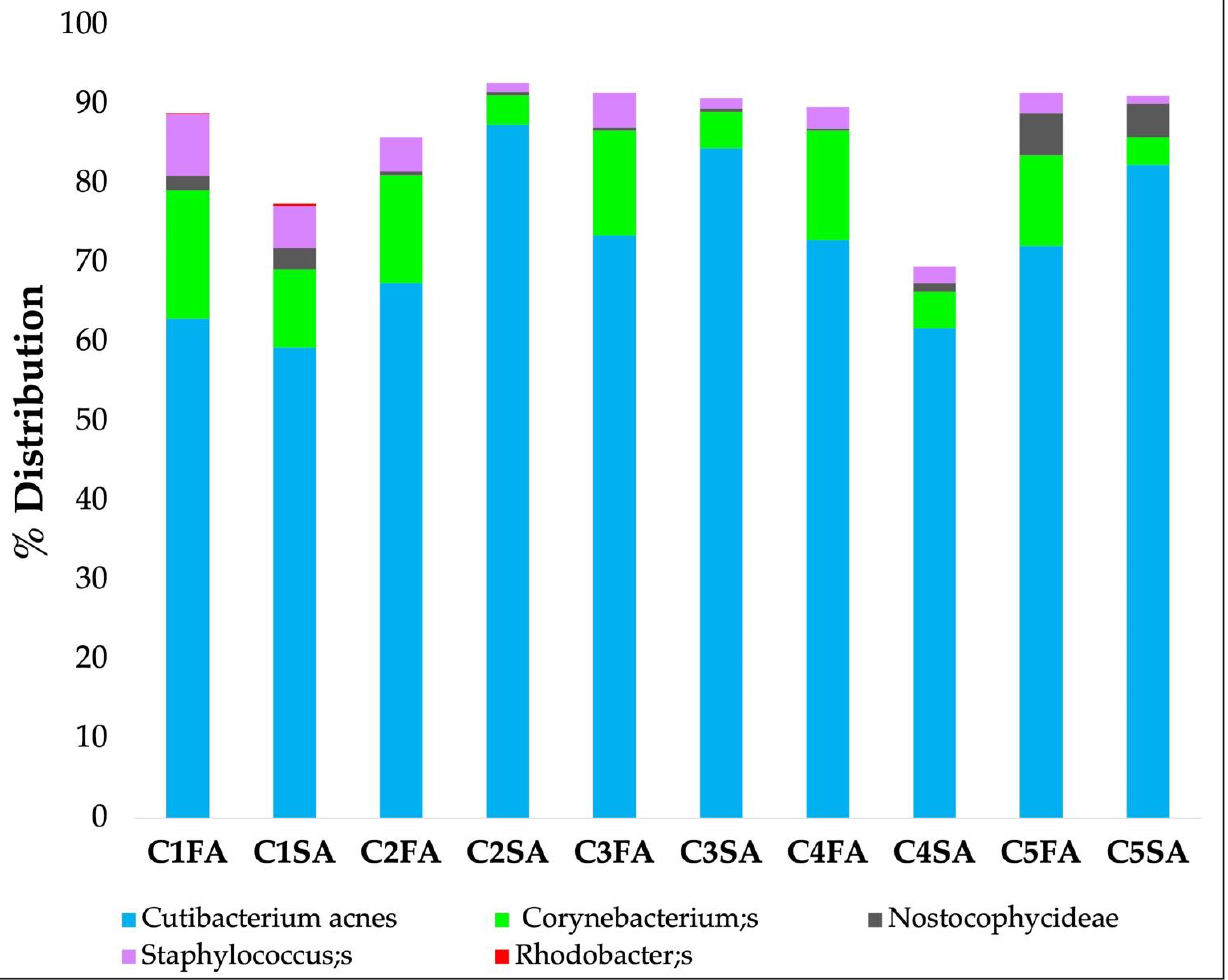
Figure 4. Bacterial species-level profile distribution on 5 strips separately collected and analyzed (from C1 as the outermost layer to C5 as the innermost layer), taken from the forehead A area (FA) and shoulder A area (SA). Table 5. Mean bacterial species-level profile distribution obtained by analyzing two strips together (strip 2 and strip 3, C2- 3) both in the forehead area (FA) and the shoulder area (SA).